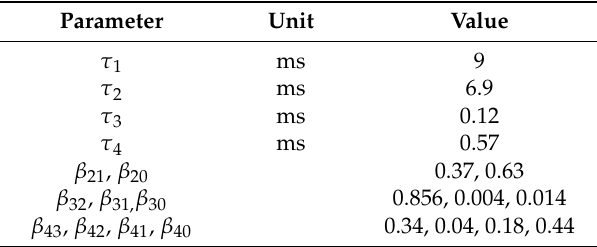
Table 2. Branching ratios and level lifetimes.